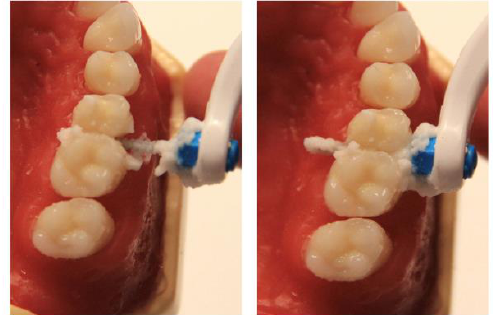
Figure 5. Interdental brushes in action.